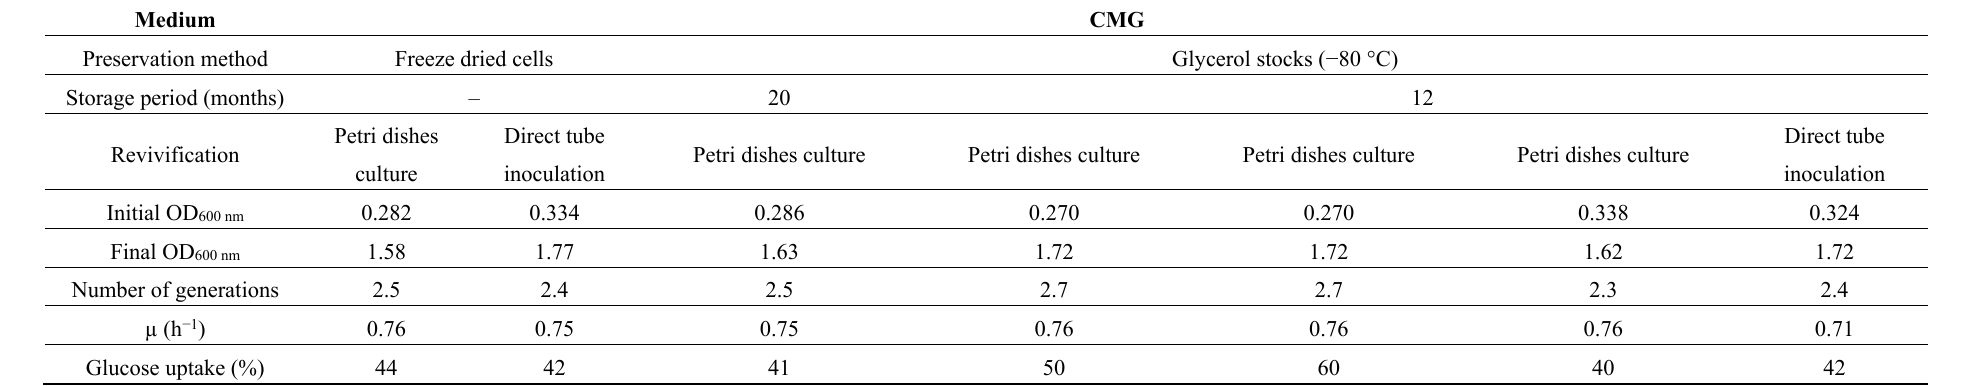
Table 3. Effect of the strain preservation methods, the frozen storage period, the type of strain revivification and the variability between colony forming unit on Petri dishes on the culture of Deinococcus geothermalis DSM-11302 in CMG.